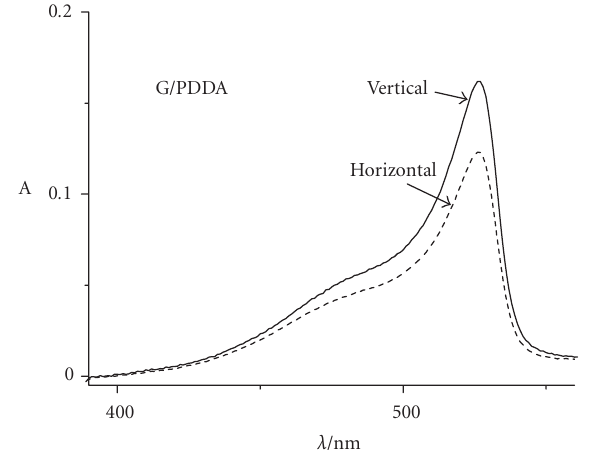
Figure 5: Absorption of a G/PDDA multilayer (5 bilayers per side of the quartz plate) measured with polarized light. Incidence angle = 30 ◦ ( β app , see the experimental section).